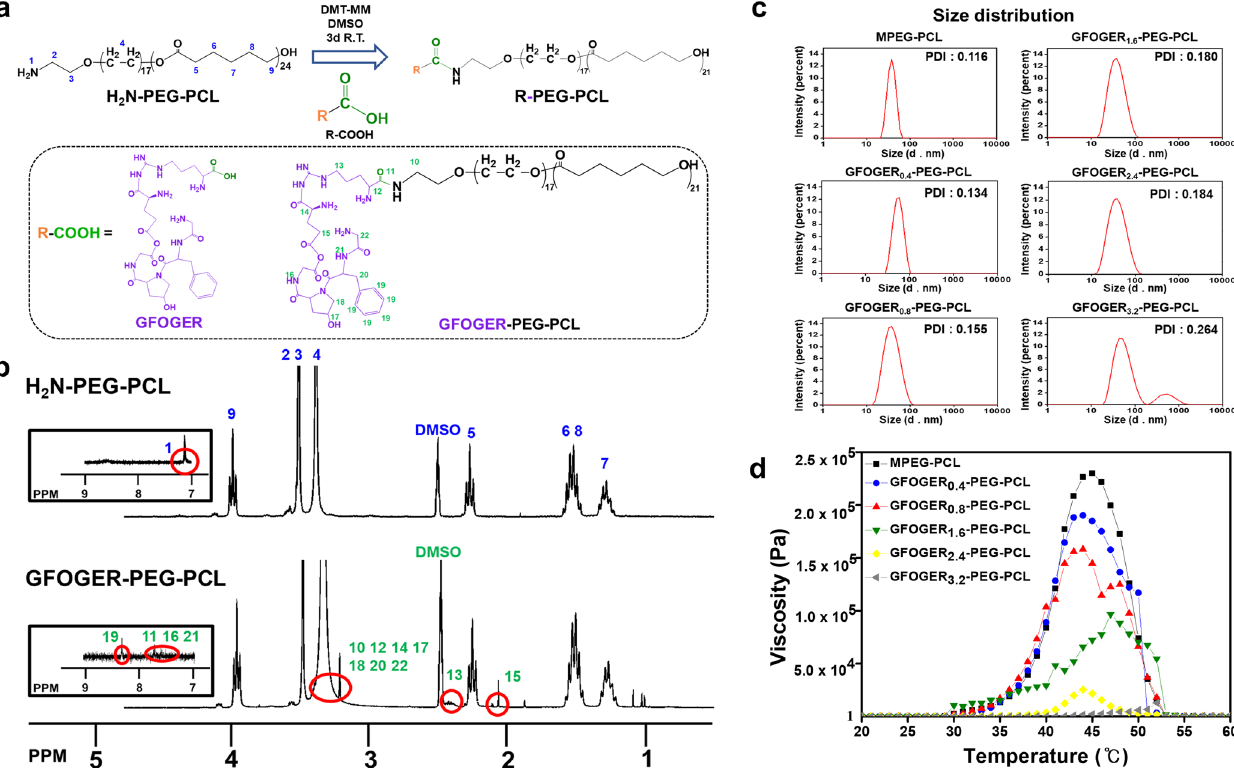
Fig. 2 Synthesis and characterization of GFOGER-PEG-PCL. a Synthetic scheme of GFOGER-PEG-PCL. Conjugation of GFOGER via condensation reaction using DMT-MM as a condensing agent. b 1 H NMR spectra of GFOGER-PEG-PCL polymer measured in DMSO- d6 . c Particle size distribution of copolymer micelles in water measured by DLS at 25 °C. d Viscosities of MPEG-PCL, GFOGER 0.4 -PEG-PCL, GFOGER 0.8 -PEG-PCL, GFOGER 1.6 -PEG-PCL, GFOGER 2.4 -PEG-PCL, and GFOGER 3.2 -PEG-PCL hydrogel precursor solutions monitored from 20 to 60 °C by